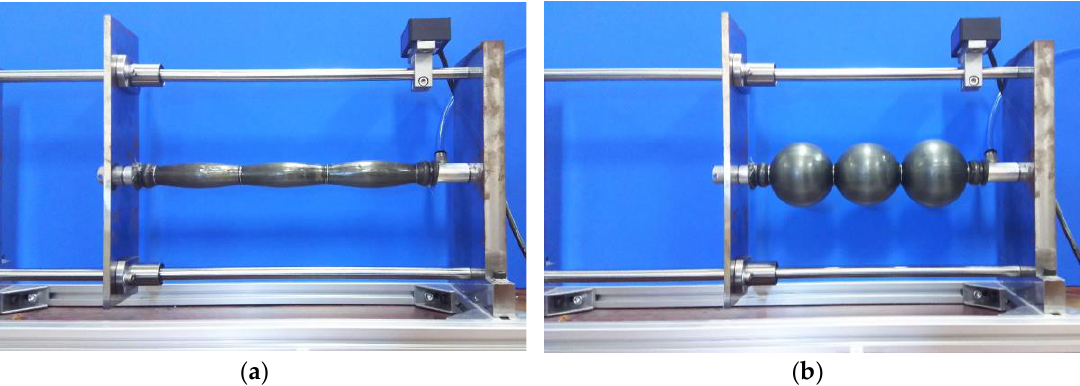
Figure 1. The straight-fiber artificial muscle (( a ) air released, ( b ) air applied).